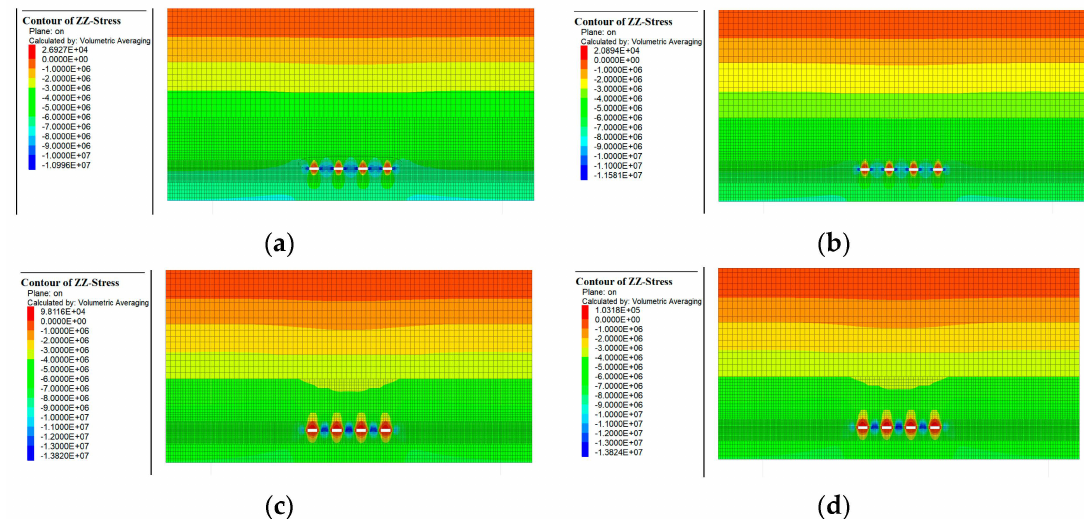
Figure 6. Stress distribution of rock strata in various conditions (Pa). ( a ) norm mining. ( b ) thermal stress. ( c ) rock burnt. ( d ) synergistic